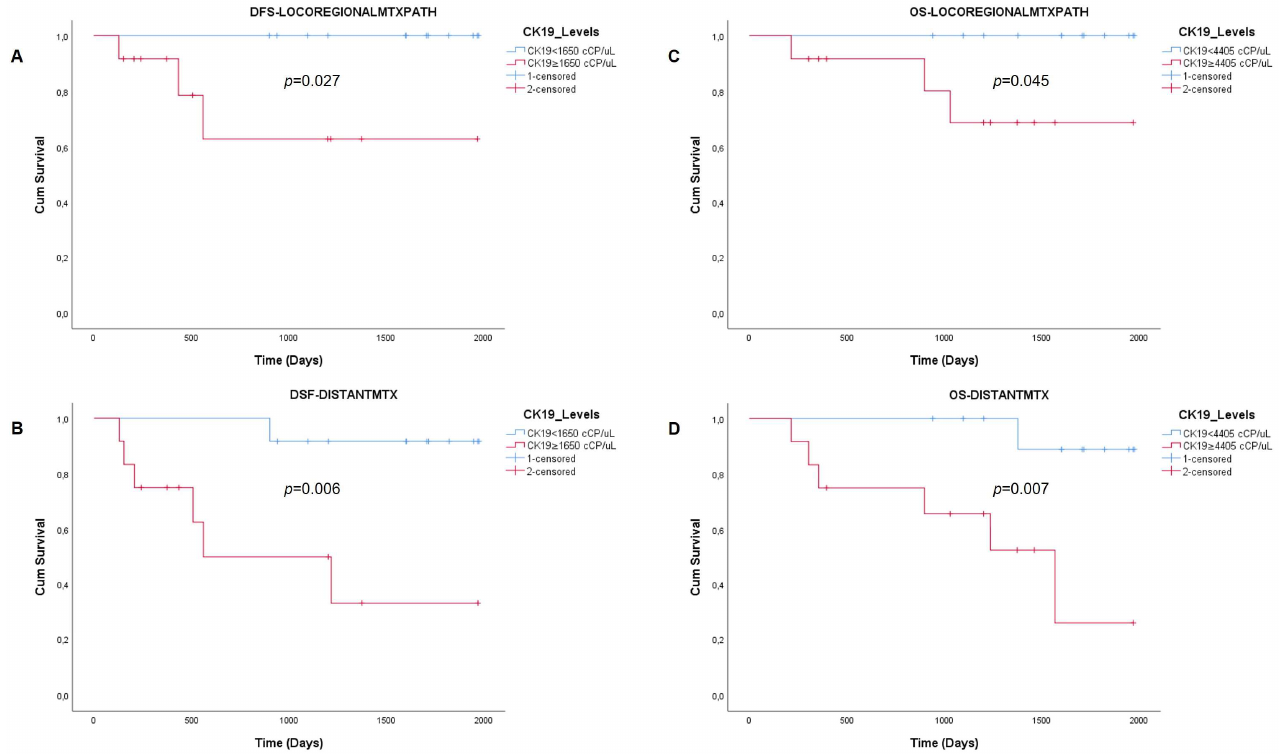
Figure 6. Kaplan-Meier curves comparing OS and DFS distribution in patients with high or low levels of CK19, and the appearance of loco-regional and distant metastasis. ( A ). DFS curve for patients harboring loco-regional metastasis with high survival probability (<1650 cCP/uL) vs. patients with low survival probability ( ≥ 1650 cCP/uL) p -value = 0.006. ( B ) DFS curve for patients harboring distant metastasis with high survival probability (<1650 cCP/uL) vs. patients with low survival probability ( ≥ 1650 cCP/uL) p -value = 0.045. ( C ) OS curve for patients harboring loco-regional metastasis with high survival probability (<4405 cCP/uL) vs. patients with low survival probability ( ≥ 4405 cCP/uL) p -value = 0.045. ( D ) OS curve for patients harboring distant metastasis with high survival probability (<4405 cCP/uL) vs. patients with low survival probability ( ≥ 4405 cCP/uL) p -value =